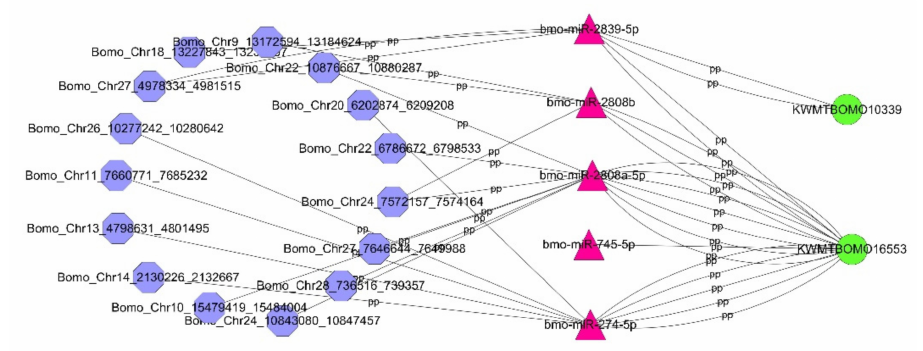
Figure 7. The display of circRNAs-miRNAs-mRNA regulatory network for cocoon color formation of the yellow and white cocoon silkworm, B. mori . The purple diamond represents circRNA, the red triangle represents miRNA, and the green circle represents mRNA.